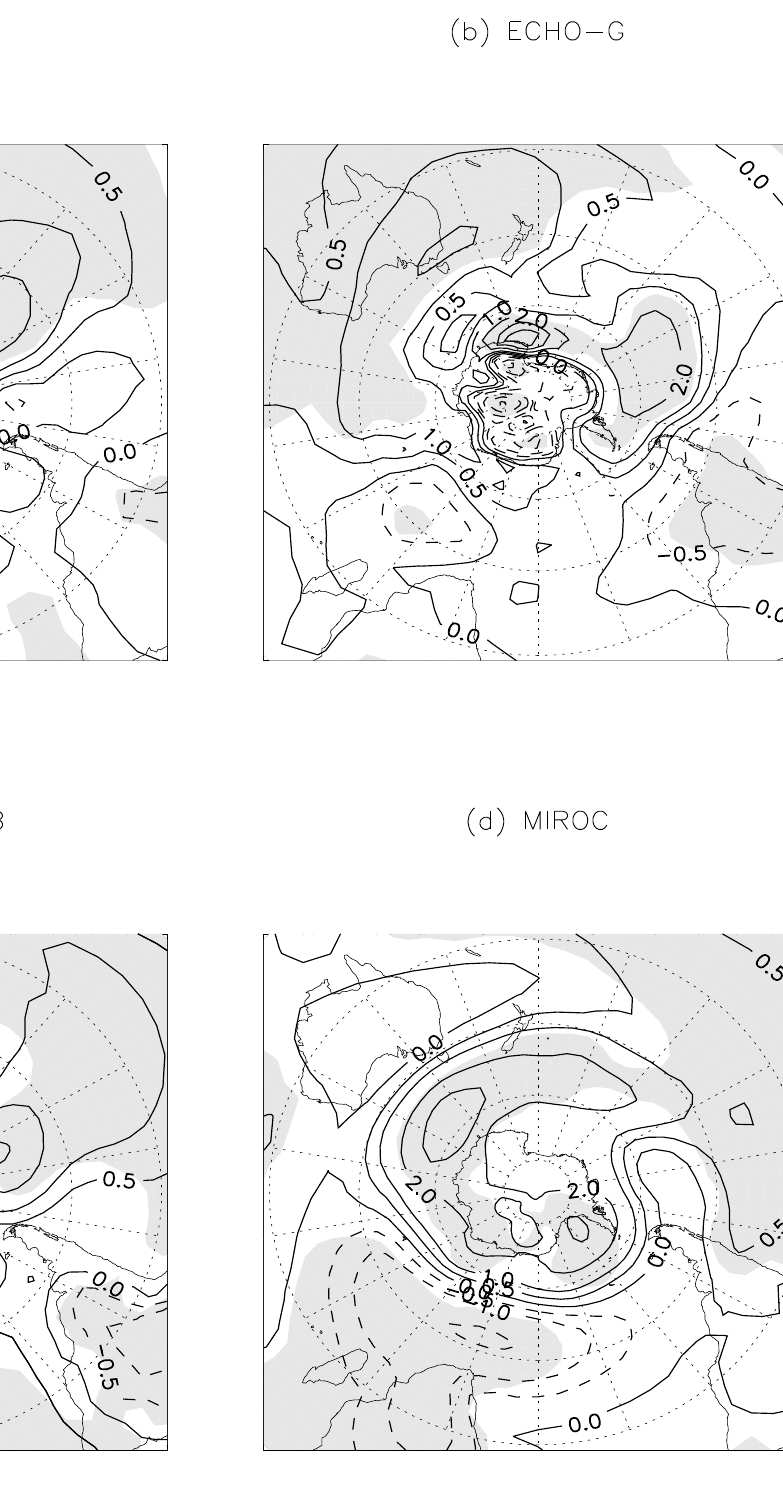
Fig. 5. The same as Fig. 3 except for JJA